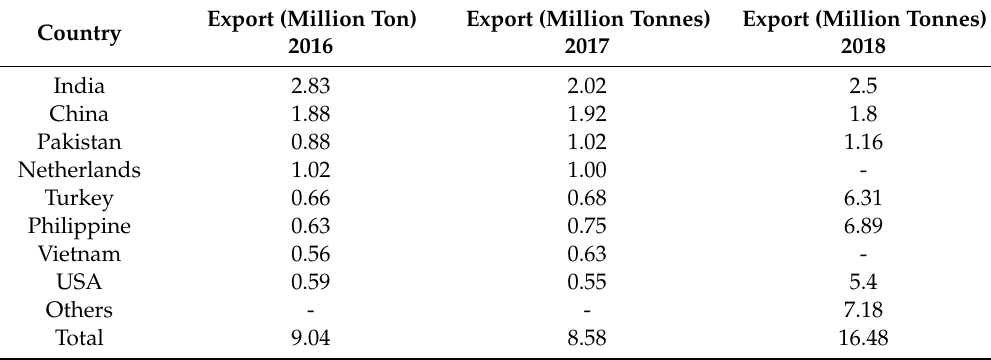
Table 1. Palm oil export market by country in 2016, 2017 and 2018